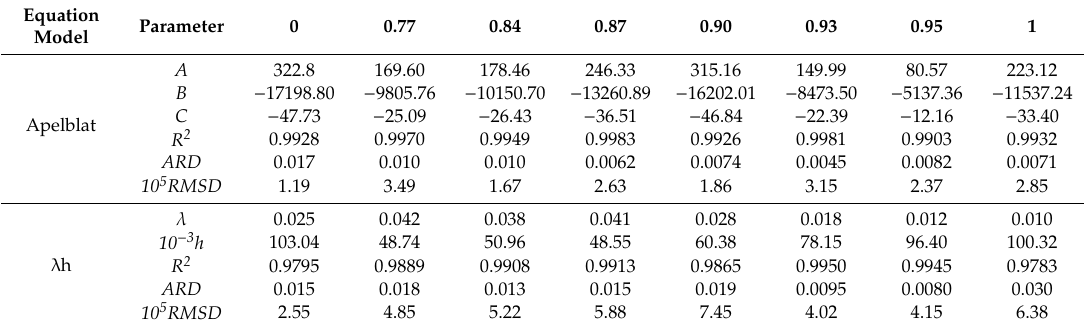
Table 2. Regressed parameters ARD and RMSD for L-Phe in di ff erent water activities by Apelblat and λ h